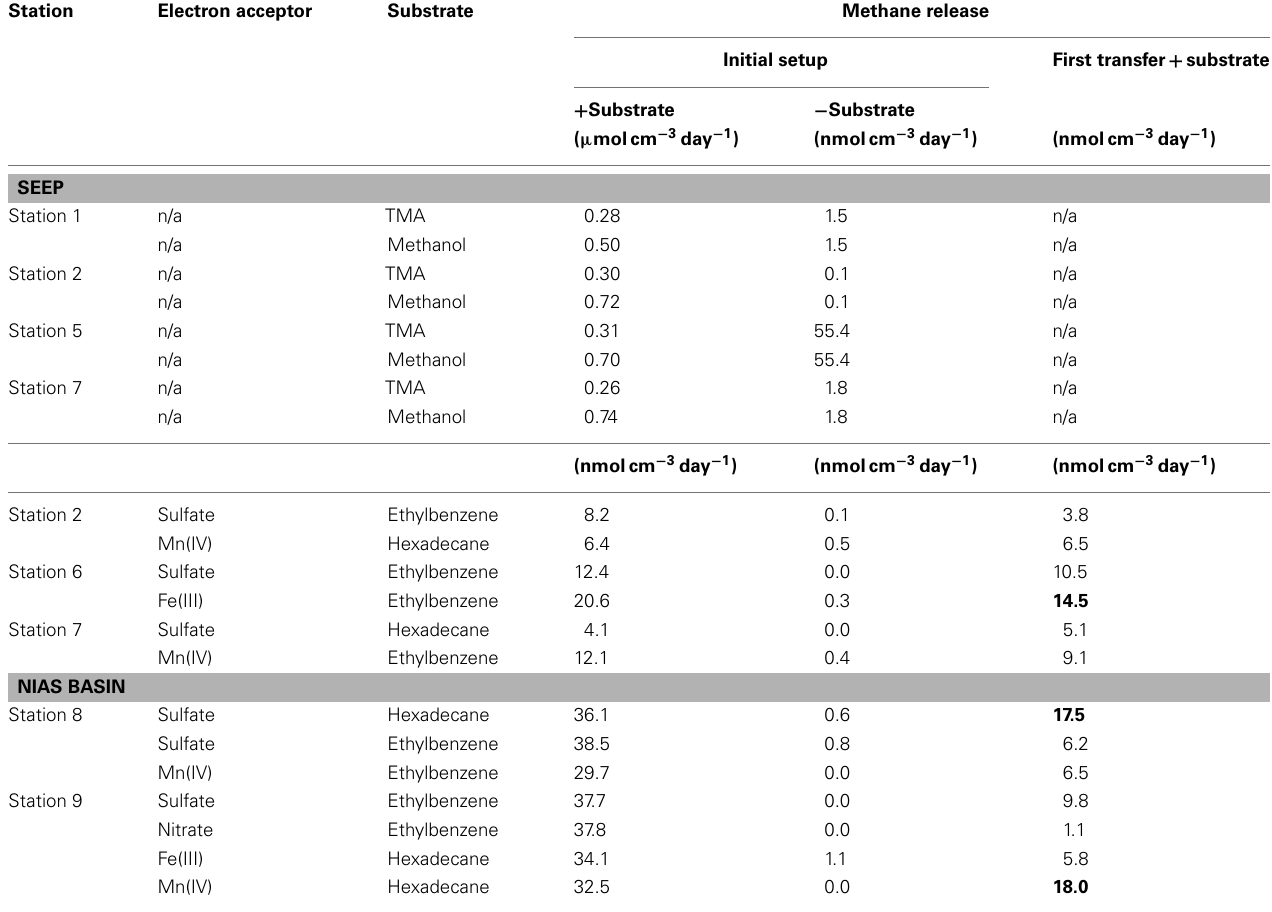
Table 4 | Rates of methane release whenTMA, methanol, or hydrocarbons were fed to the microcosms.